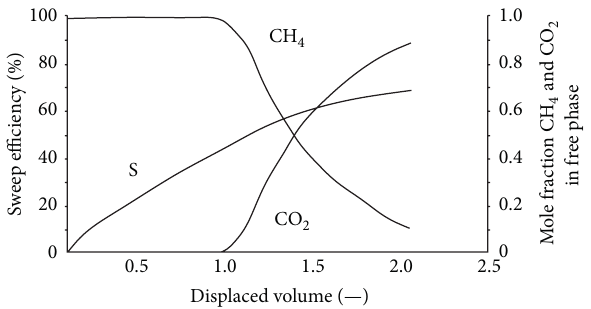
Figure 15: The sweep efficiency and molar concentrations of the produced gas against the displaced volume.